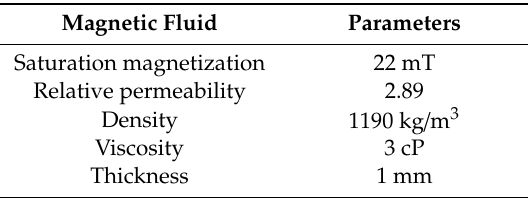
Table 1. Parameters of the magnetic